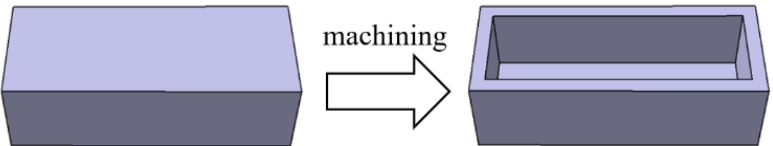
Figure 4. Machined thin ‐ walled part.